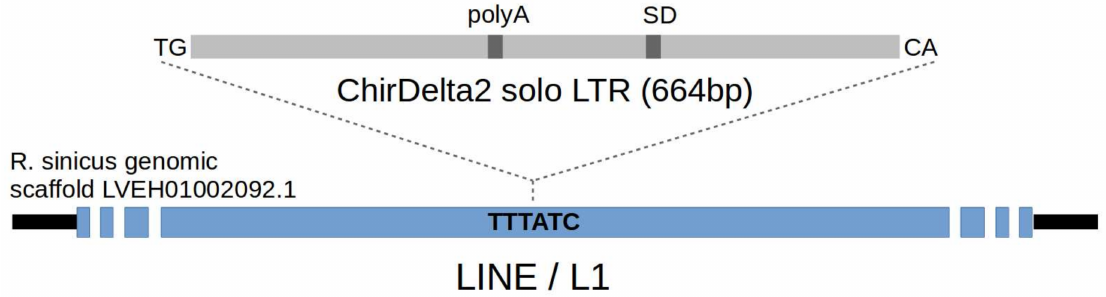
Figure 1. Schematic of the endogenous deltaretroviral sequence integrated in genome of rhinolophid bats. Canonical TG and CA dinucleotides at the ends of LTR sequence, polyadenylation site (polyA) and splice donor site (SD) are depicted. Integration of LTR sequence into the LINE element (blue) present in rhinolophid genome is indicated by dashed lines. 6-bp long target site sequence is marked by bold letters—this sequence has been duplicated upon the integration of